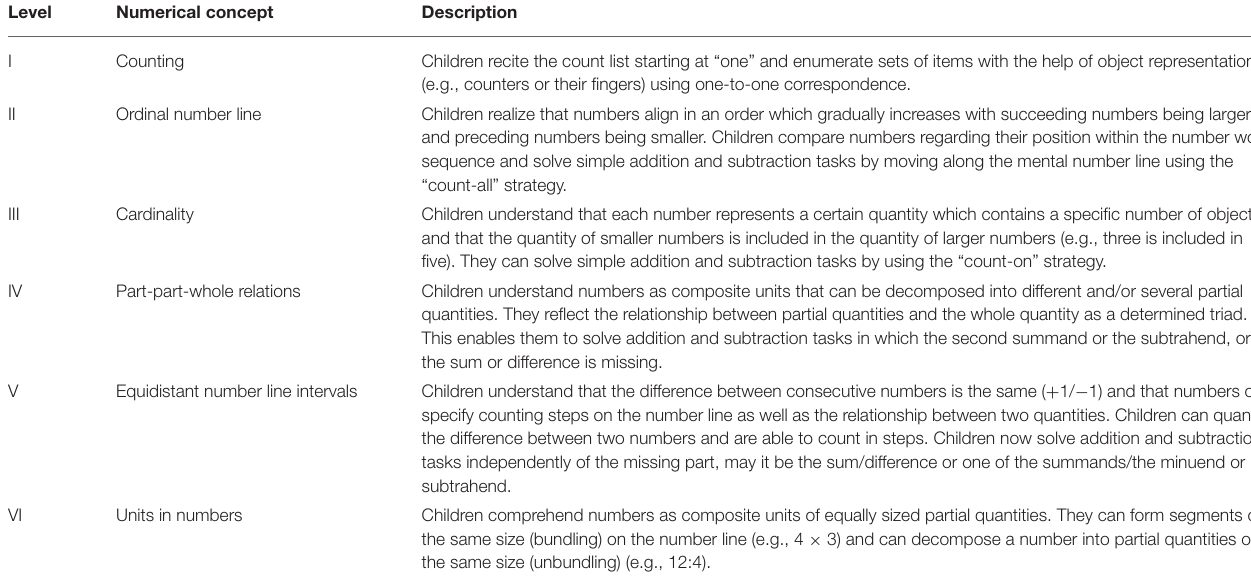
TABLE 1 | Development model of conceptual numerical understanding by Fritz et al. (2013). Level